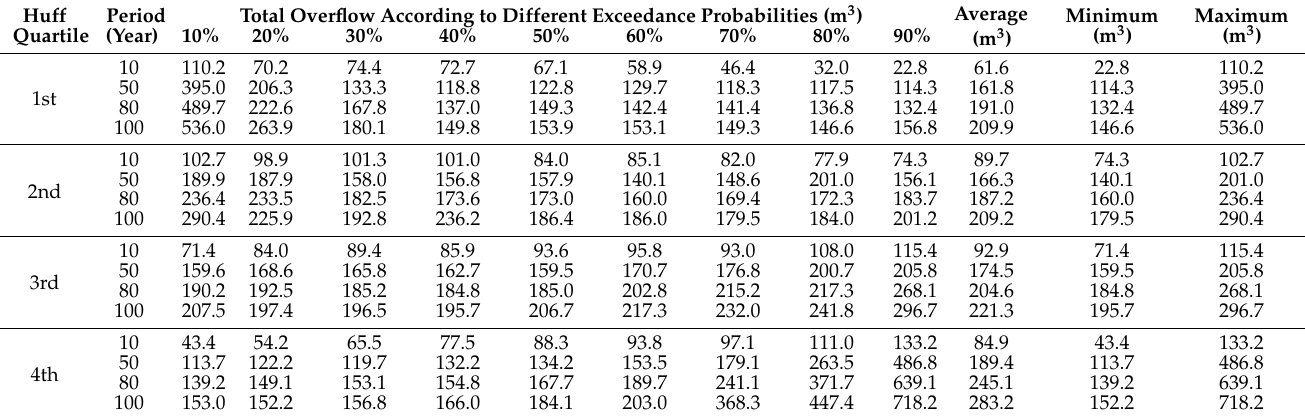
Table 2. The EPA-SWMM-model-simulated 1-h total overflow